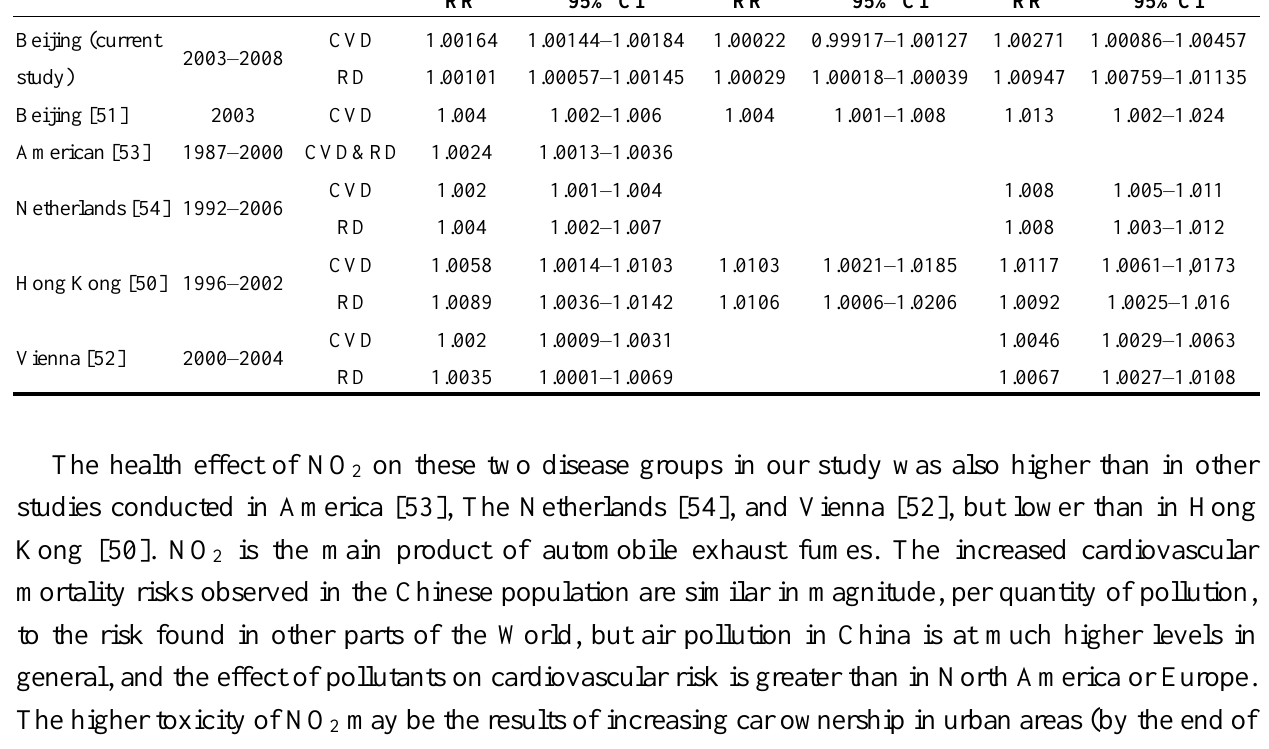
Table 7. Comparison of RR for a 10 µg/m 3 increase in pollutant concentration worldwide.